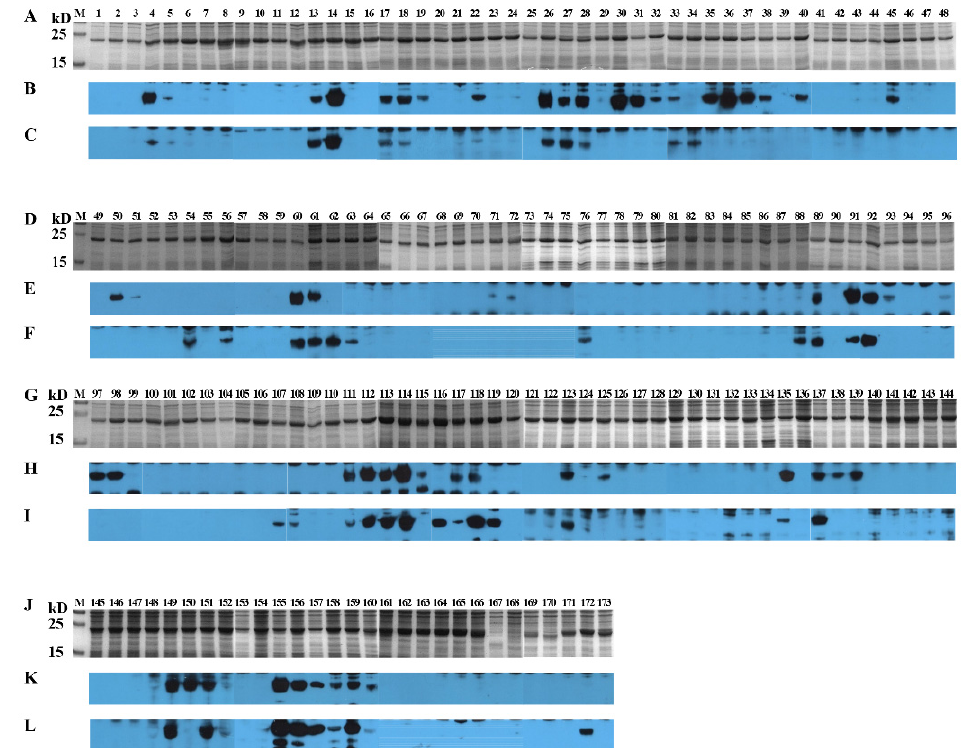
Figure 7. SDS-PAGE and Western blotting analysis of 16-mer- and 10-mer S SD2014 -derived peptides. One hundred and seventy-two 16-mer peptides and one 10-mer peptide covering the entire S SD2014 were GST-fusion expressed in E. coli BL21. After induction, cells were harvested by centrifugation, and cell pellets were resolved by SAS-PAGE using 15% gels. Gels were either stained or processed for Western blots. PVDF membranes were first blocked with 5% ( w / v ) skimmed milk, incubated sequen- tially with anti-S serum and goat anti-rabbit IgG, and then visualized by enhance chemiluminescence. ( A , D , G , J ): SDS-PAGE analysis of 172 GST-fusion expressed 16-mers and one 10-mer. ( B , E , H , K ): Western blot analysis of 172 GST-fusion expressed 16-mers and one 10-mer with anti-S SD2014 serum. ( C , F , I , L ): Western blot analysis of 172 GST-fusion expressed 16-mers and one 10-mer with anti-S CV777 serum. 1–173: GST-fusion expressed 16-mers (P1–P172) and 10-mer